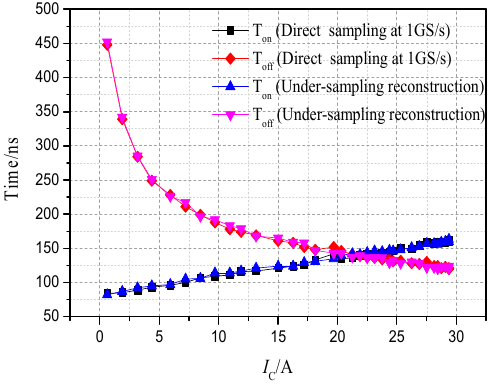
Figure 11. Experimental waveforms of V CE and I C in the PWM converter test.